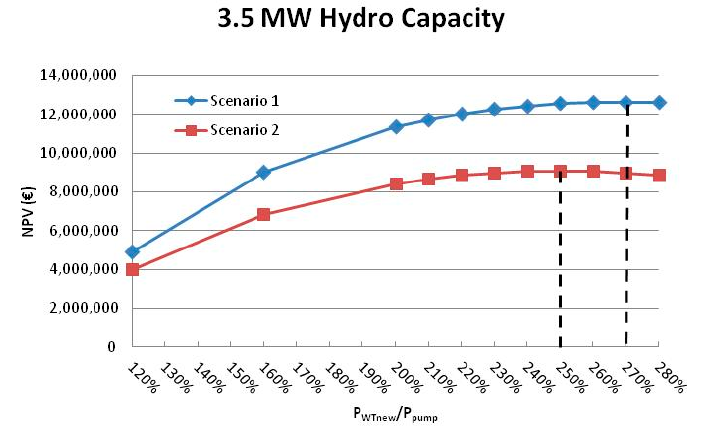
Figure 6. Comparison of the two billing scenarios considering P hydro = 3.5 MW.